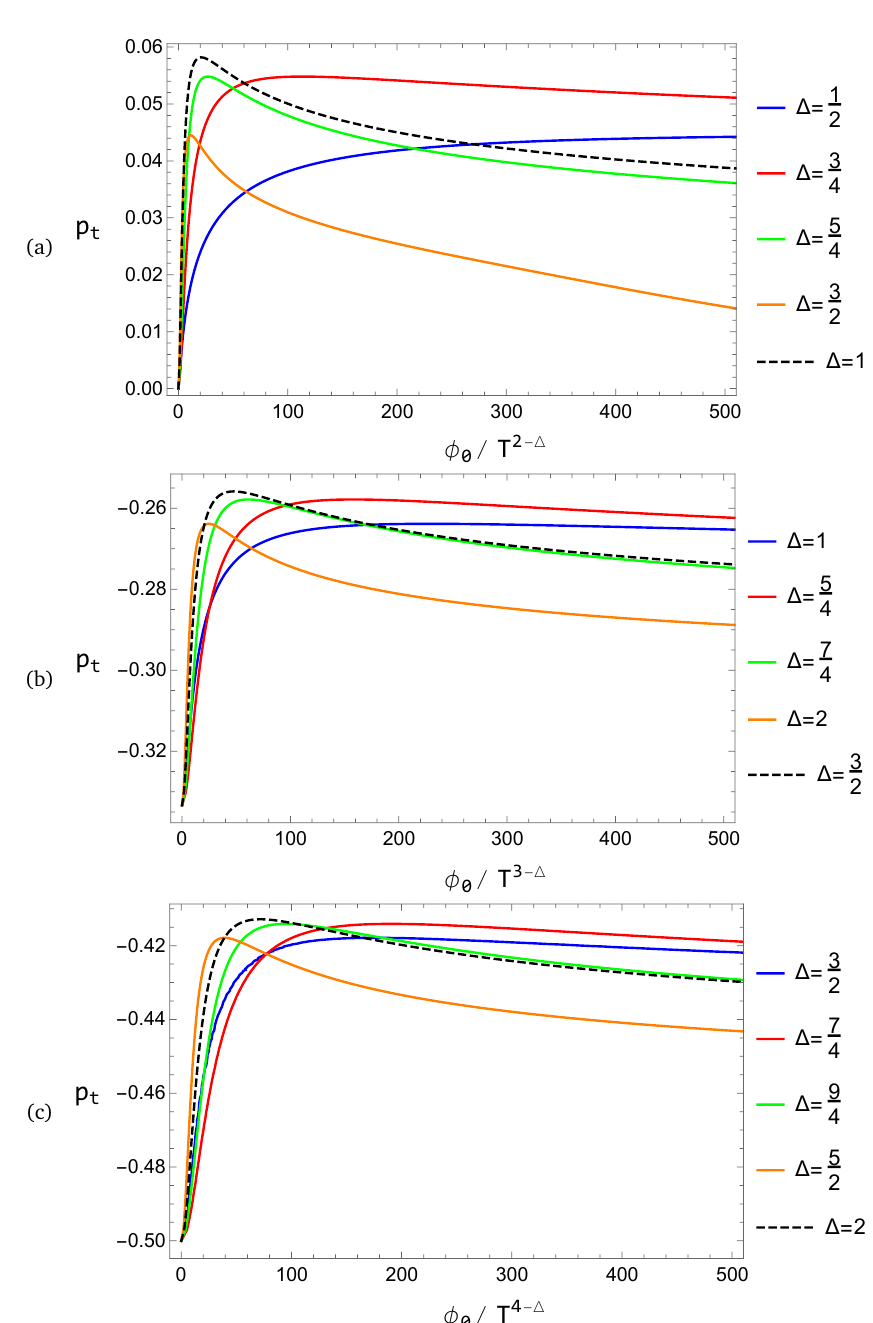
Figure 3: The emergent Kasner exponent p versus the dimensionless deformation t / T d − ∆ for various d and ∆ , computed via a numerical shooting method parameter φ 0 outlined in Appendix B. We show the results for (a) d = 2, (b) d = 3, and (c) d = 4. The dashed lines correspond to ∆ = d /